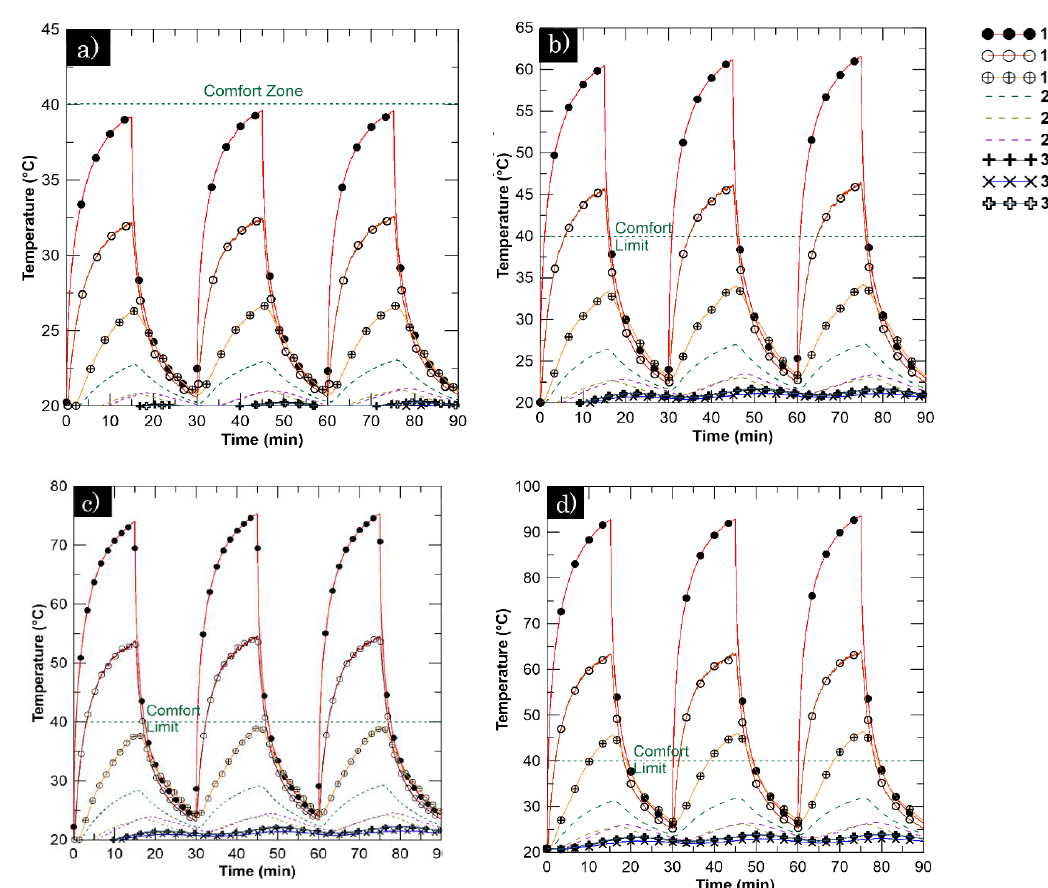
Figure 7. The baseline temperature profile for the experimental tablet PC at various power input without any PCM TES units: ( a ) 2 W, ( b ) 4 W, ( c ) 6 W and ( d ) 8 W.